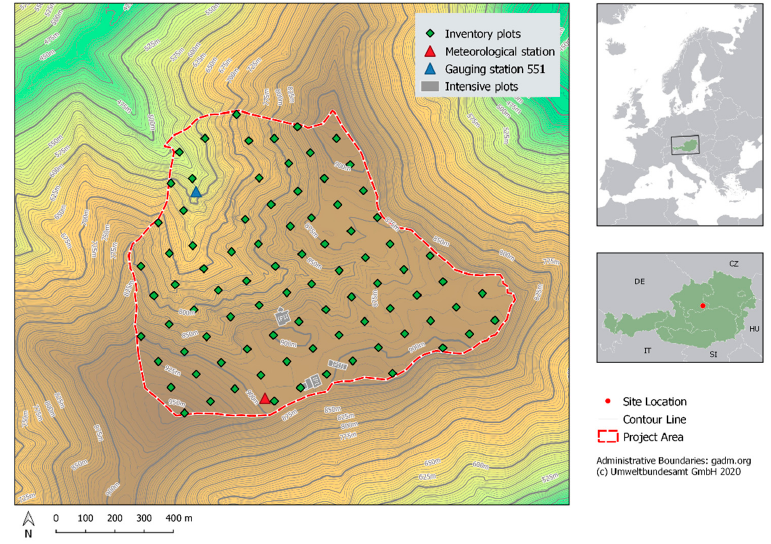
Figure 1. Location of LTER Zöbelboden with the main monitoring installations.